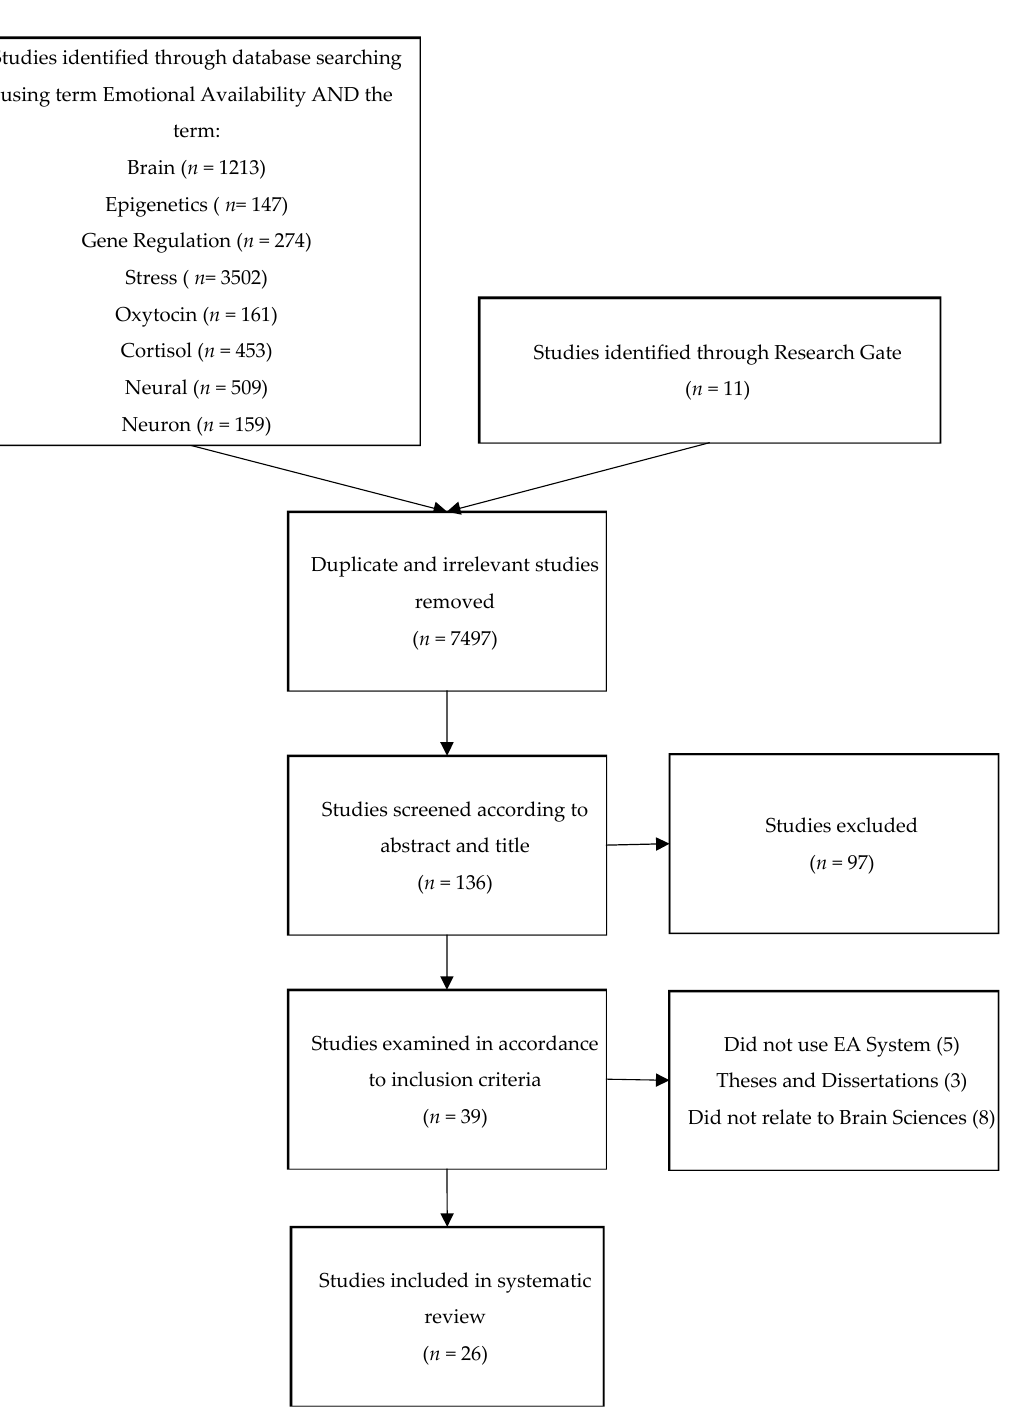
Figure 1. Literature search process and study selection flow.